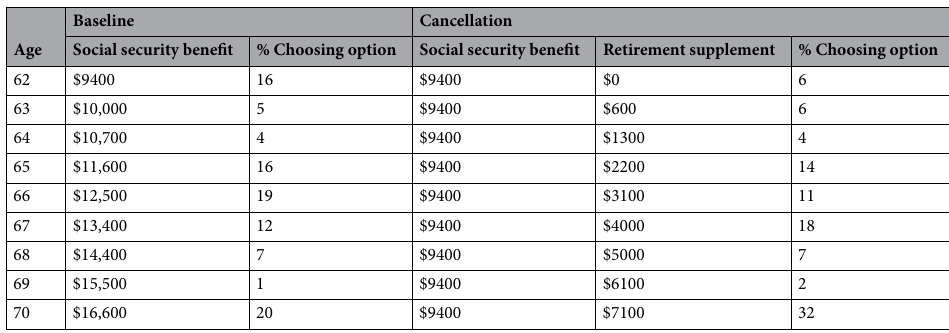
Table 4. Stimuli and results from Experiment 4. Percentages indicate the percent of participants under 62 years of age choosing each retirement